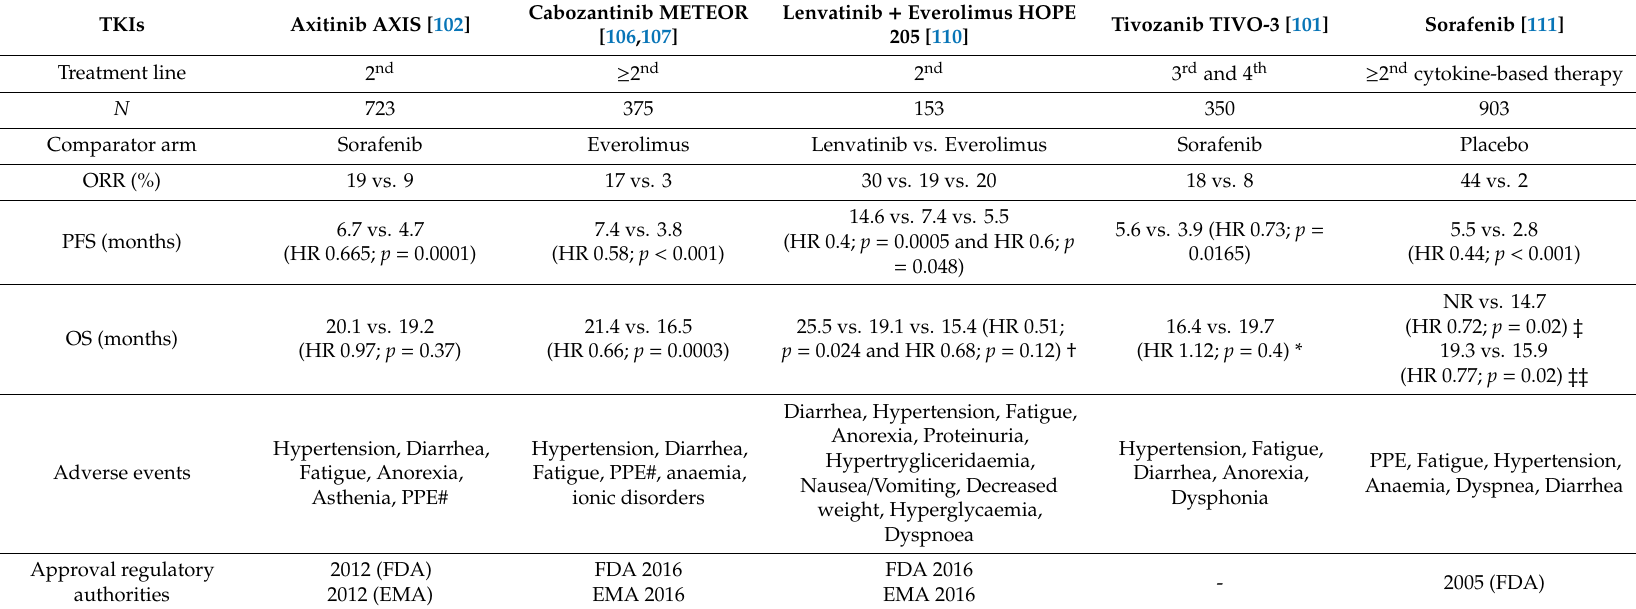
Table 2. TKIs evaluated in phase II and III clinical trials in patients that have received previous treatment. * Interim analysis. # PPE: Palmar-plantar erythrodysaesthesia. † Updated results (cuto ff date December 10th, 2014). ‡ After a median follow up of 6.6 months. ‡‡ After 47.7% of patients in the placebo arm had switched to